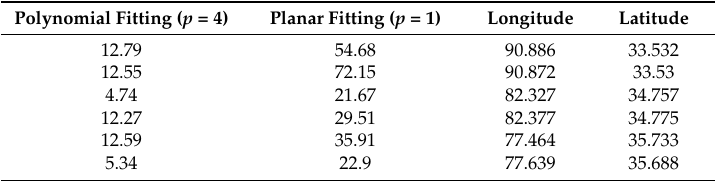
Figure 5 . ( a , b ): the fitted surface and real surface when p = 1; ( c , d ): the fitted surface and real surface when p = 4. The light blue surface represents the fitted surface and the gradient colored surface represents the real surface. Table 2. The RMSE value (m) between fitted glacial surface and real glacial surface for the cases of polynomial fitting ( p = 4) and of planar fitting ( p = 1) over six glacial facets in the